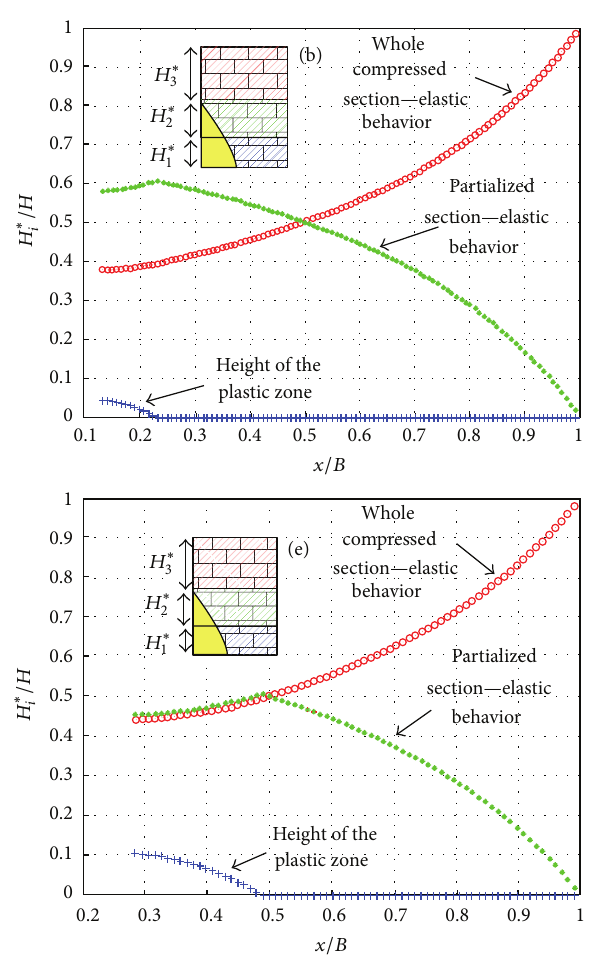
Figure 10: Variation of the dimensions of the zones characterizing the behavior of the panel.